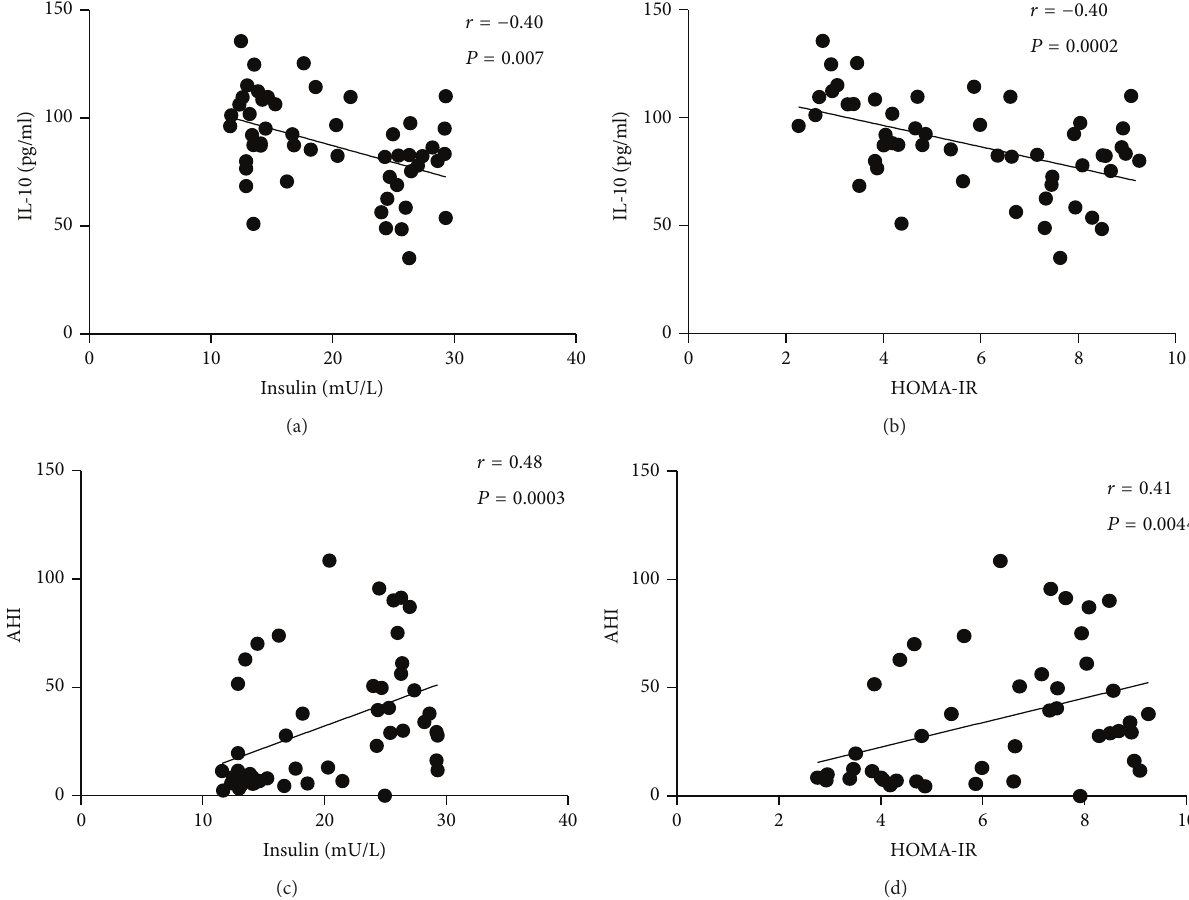
Figure2:CirculatinglevelsofIL-10showedanegativesignificantassociationwith(a)insulinlevelsand(b)HOMA-IRindex.Incontrast,AHI values were positively associated with (c) Insulin levels and (d) HOMA-IR index. Coefficient 𝑟 and 𝑃 values were calculated using Spearman’s correlation model. The correlation level was considered significant when 𝑃 < 0.05